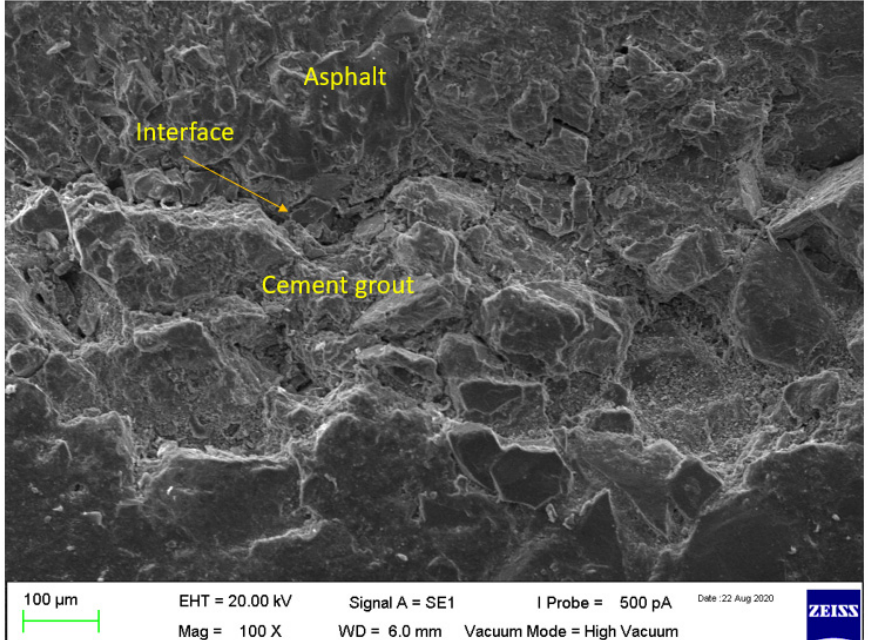
Figure 9. SEM micrograph of semi-flexible with control cement grout.